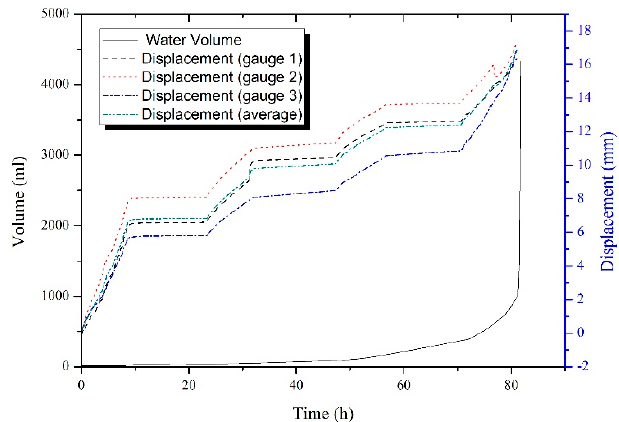
Figure 5. Volume process of injected water of stage three (Water pressure 0.13 MPa, tensile stress 0.06 MPa).